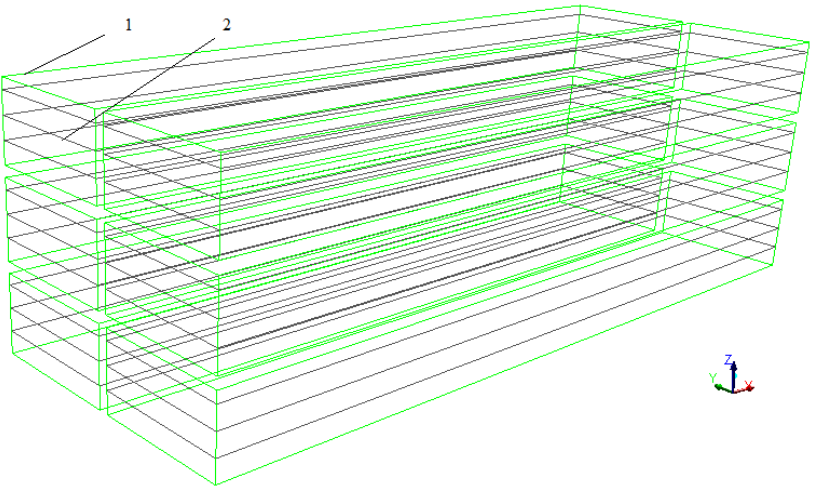
Figure 6. Schematic diagram of eighteen surfaces. 1. Porous zones; 2. Surfaces.